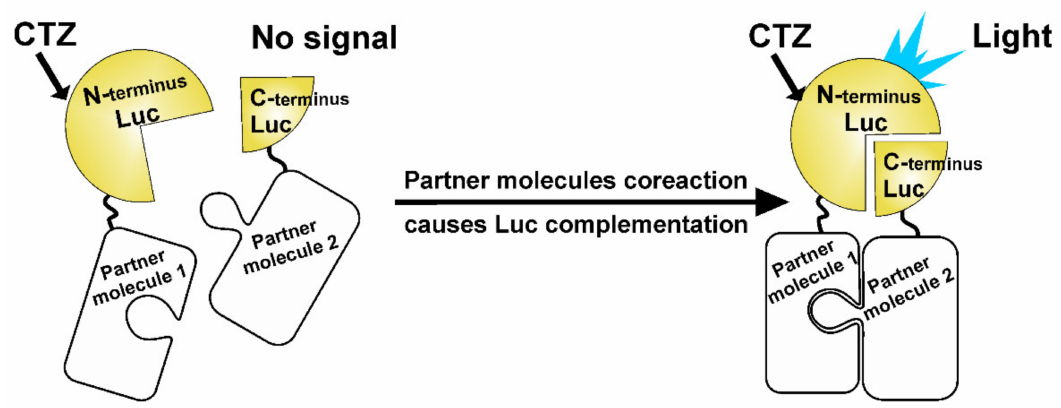
Figure 6. General principle of the assay based on the split luciferase complementation e ff